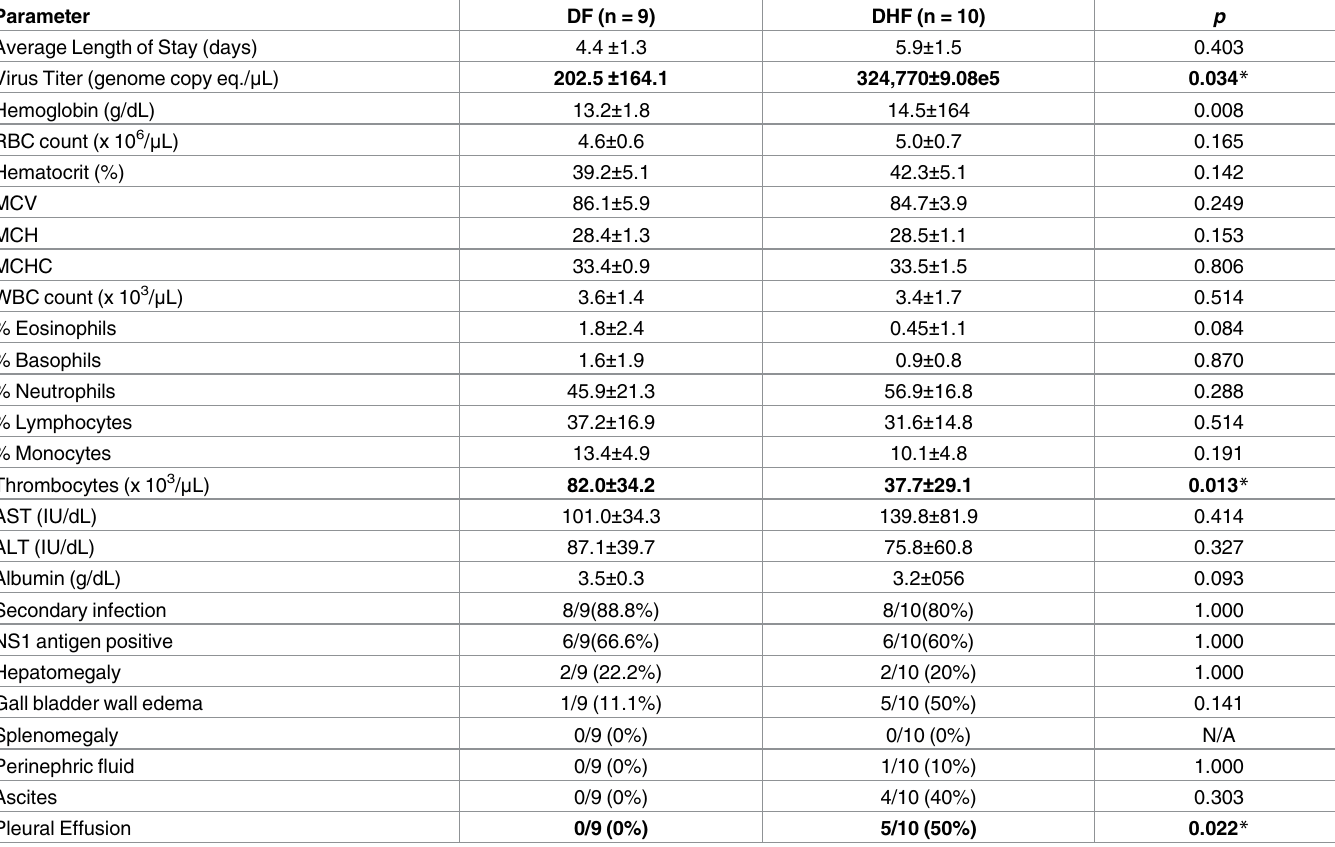
Table 3. Characteristics of dengue-confirmed adult patients (n =